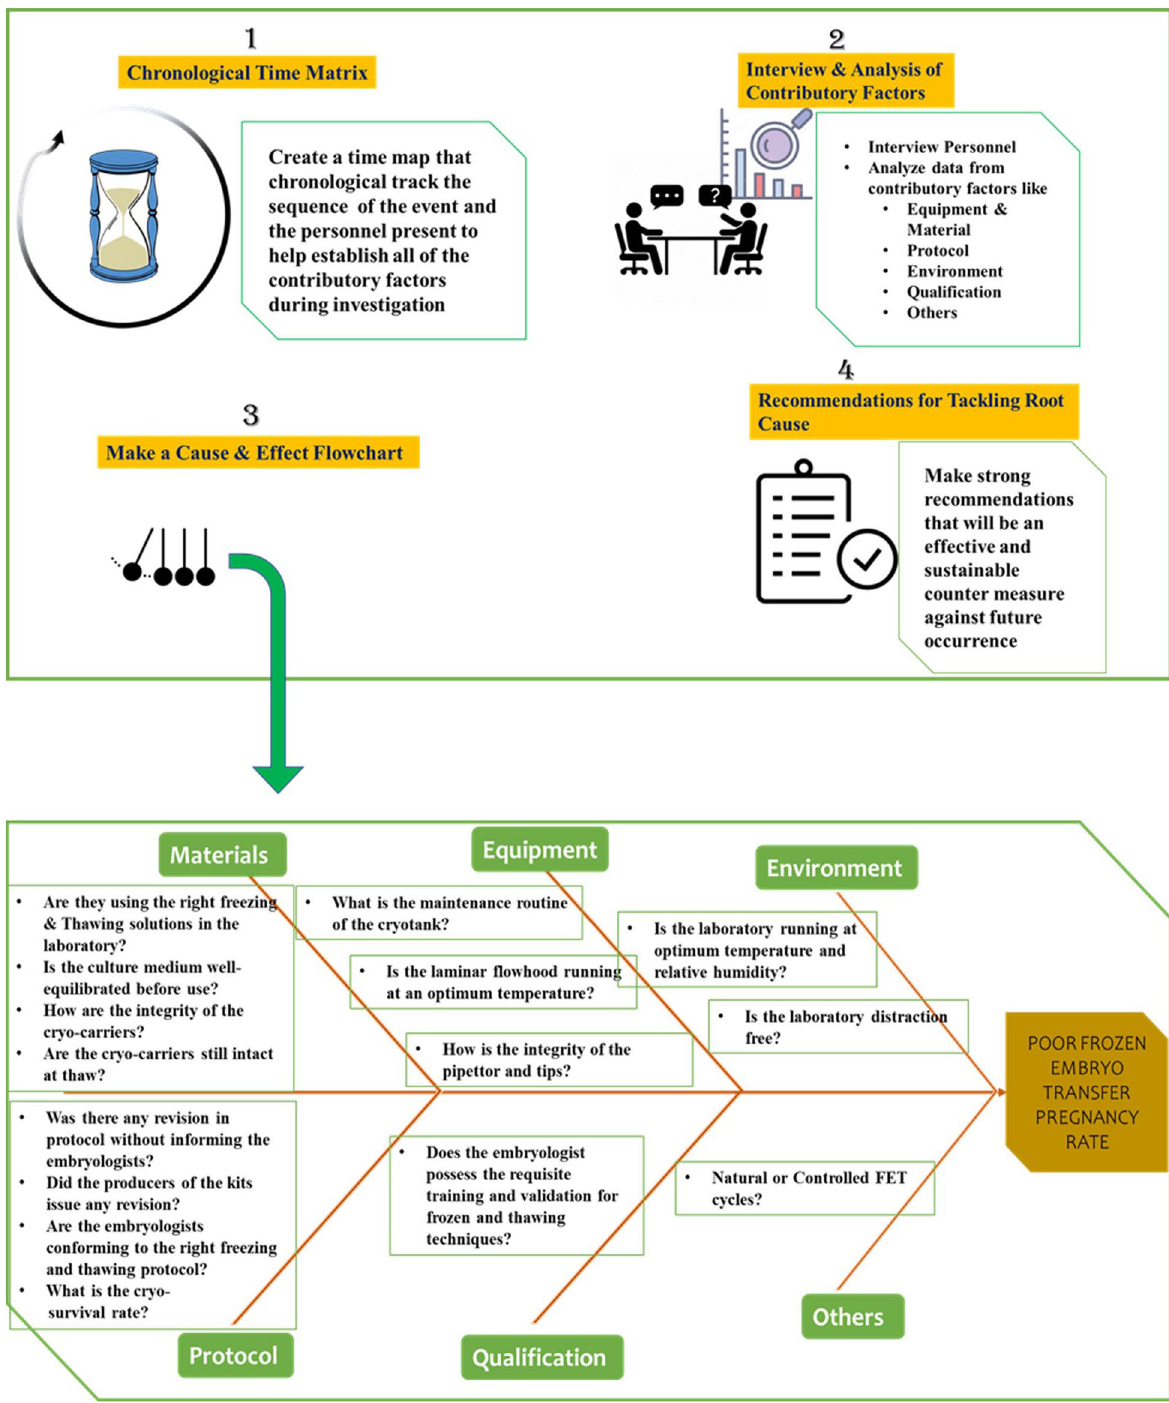
Fig. 3 Steps of root cause analysis. This schematic representation shows the 4 stages of root cause analysis (after low pregnancy rate with FET cycles). The process begins with creating a chronological time map to track the sequence of the event. It is followed by a personnel interview and investigation of contributory factors. The third stage involves making a cause and effect flowchart that will help in fabricating recommendations to tackle the root